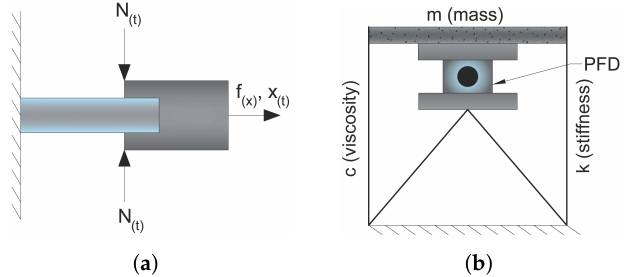
Figure 21. ( a ) Schematics of a semi-active piezoelectric friction damper; ( b ) installation of a damper on a single-story building